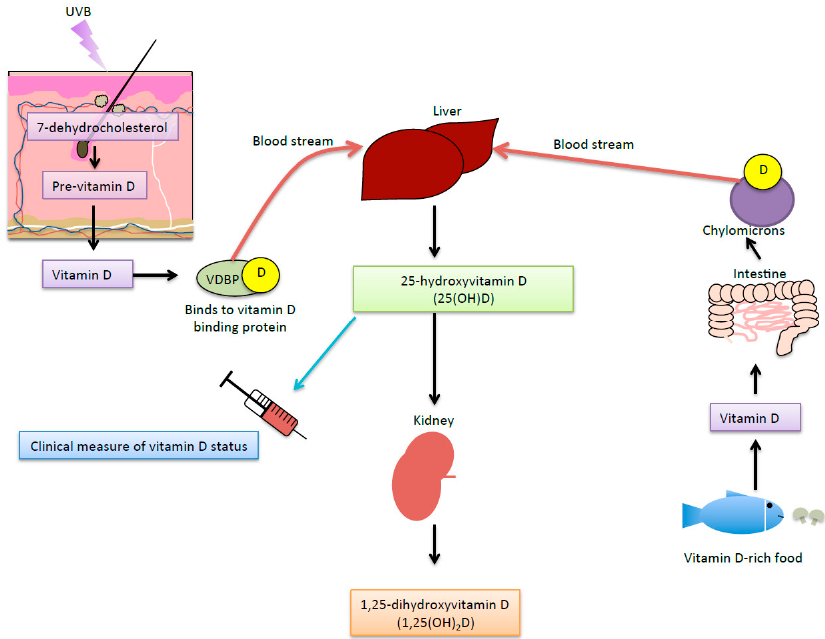
Figure 3. Vitamin D synthesis. When skin is exposed to UVB radiation, 7-dehydrocholesterol (in the skin) transforms into pre-vitamin D that isomerises with body heat into vitamin D. Free vitamin D binds to the vitamin D binding protein (VDBP), which is transported through the blood stream into the liver and is hydroxylated to form 25-hydroxyvitamin D (25(OH)D). This form of vitamin D is used as the clinical measure of vitamin D status. 25(OH)D is then transported to the kidney (and other tissues) where it is hydroxylated to form the biologically-active product 1,25-dihydroxyvitamin D (1,25(OH) 2 D). Additional vitamin D can be obtained from vitamin D-rich food sources (such as fish and mushrooms) and supplements. Vitamin D is absorbed through the intestines into the bloodstream in chylomicrons. Figure 3 was constructed based on information provided in